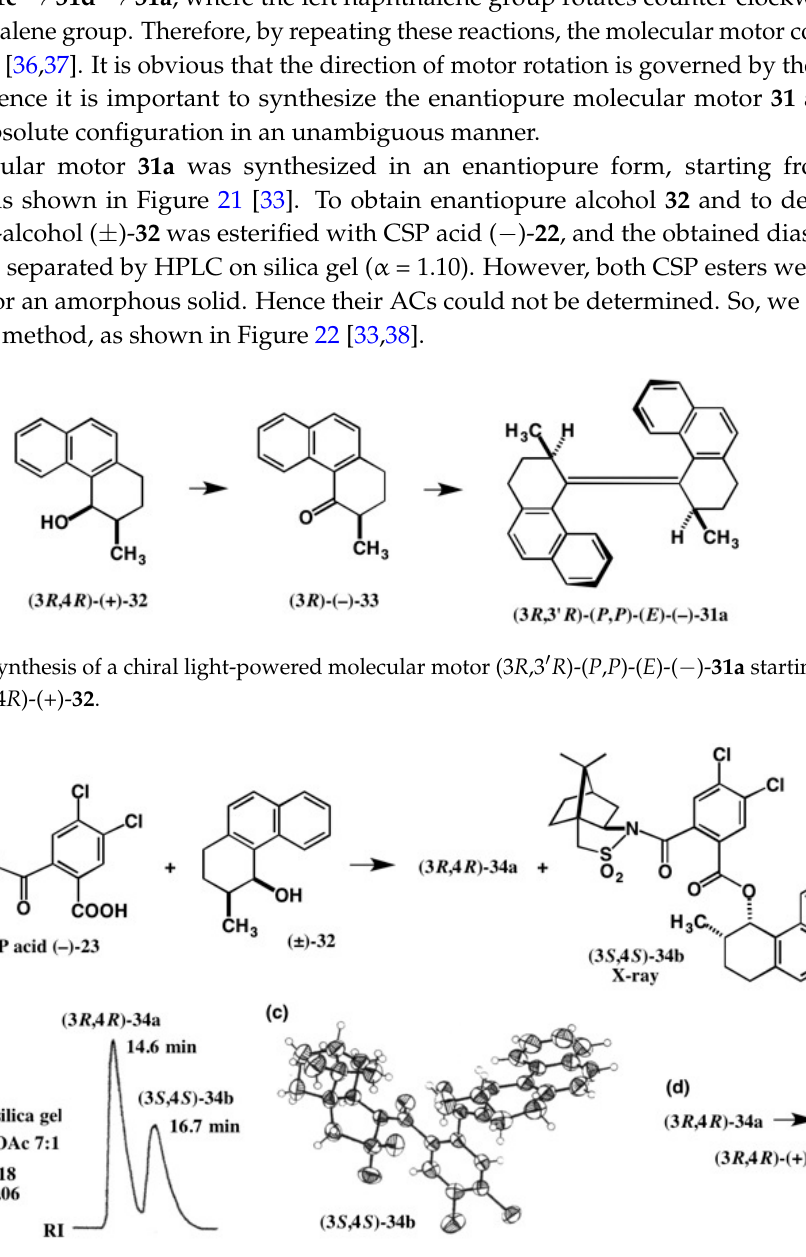
Figure 22. Preparation ( a ) and HPLC separation ( b ) of esters 34a and 34b , and the AC determination of ester 34b by X-ray analysis ( c ). From ester (3 R ,4 R )- 34a , alcohol (3 R ,4 R) -(+)- 32 was obtained ( d ). Redrawn from [38].